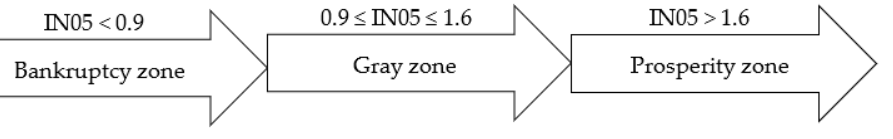
Figure 2. The resulting values of the IN05 index.